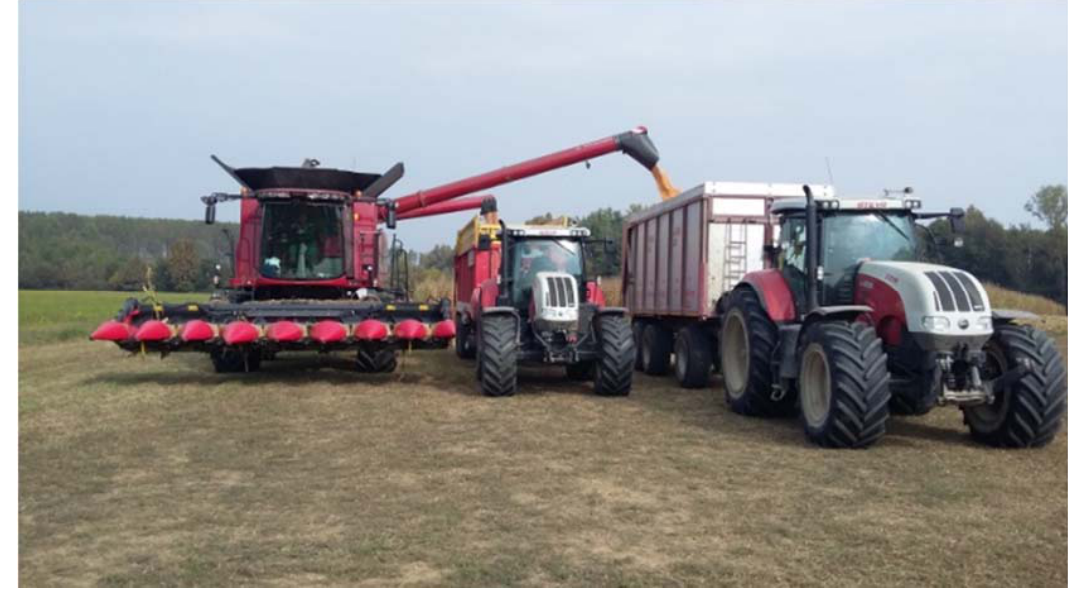
Figure 3. Simultaneous unloading phase of Maize kernel and cob tanks using Harcob